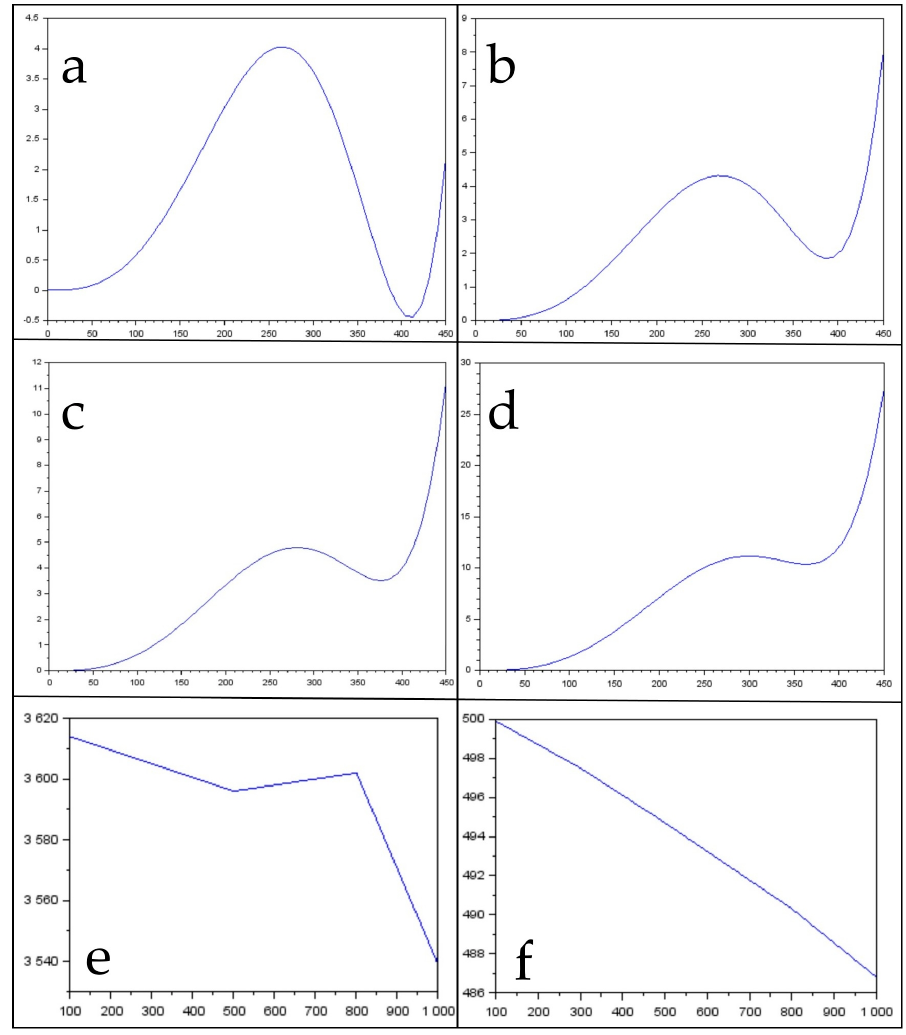
Figure 7. Distortion values for the ( a ) blue-indigo (100 pixels from the top of the image), ( b ) yellow-green (300 pixels from the top of the image), ( c ) orange-red (500 pixels from the top of the image), and ( d ) near-infrared (1000 pixels from the top of the image) parts of the spectrum, while ( e ) shows the camera constant change in relation to wavelength and ( f ) shows the change in the position of the principal point in relation to the wavelength. All values on the axis are expressed in pixels.